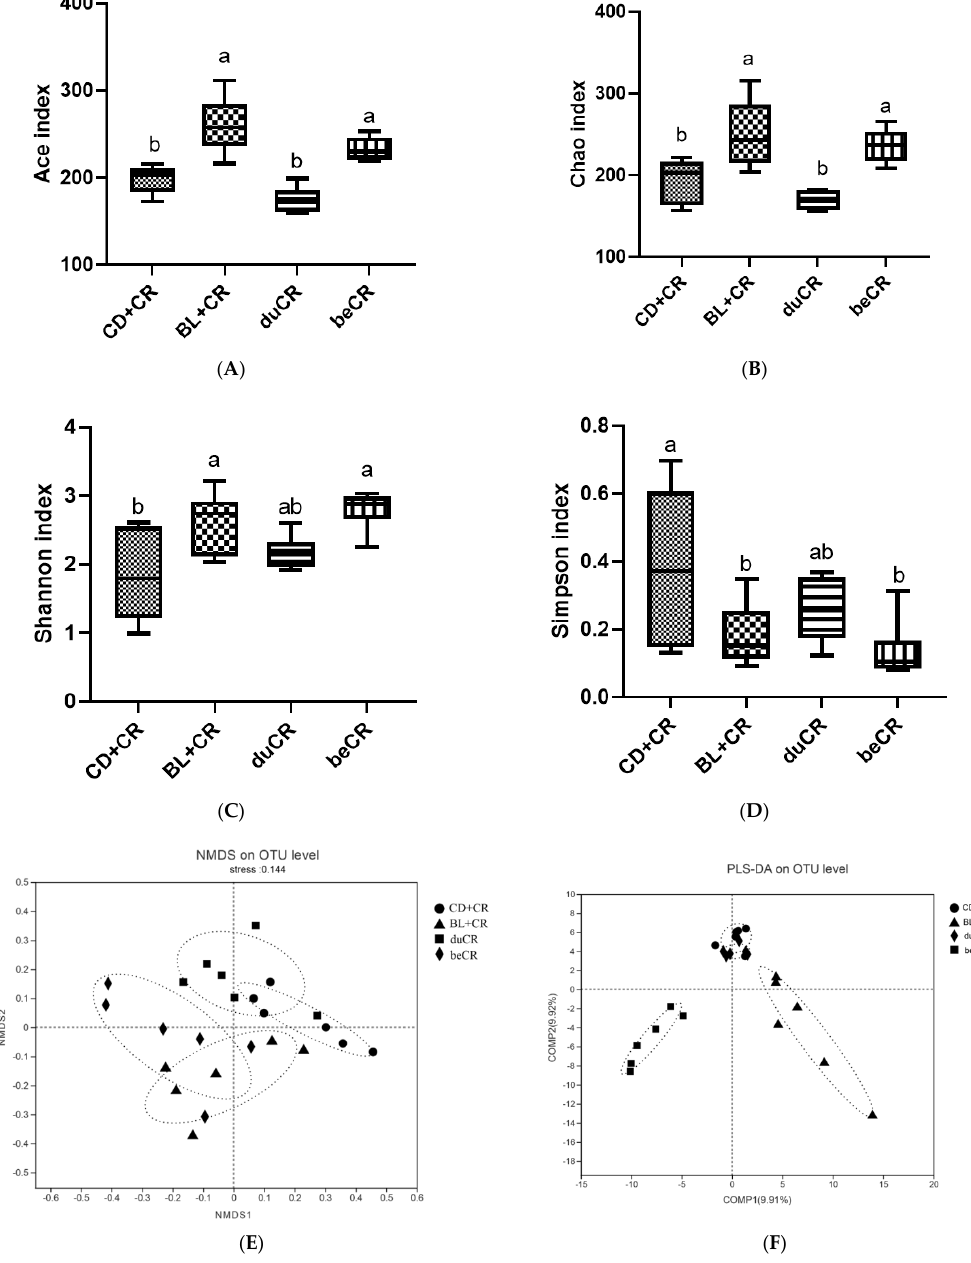
Figure 5. Effect of the beCR and duCR intervention on modulating alpha and beta diversity of intestinal flora. The richness of gut microbiota evaluated by ( A ) ACE index and ( B ) Chao index. The diversity of gut microbiota evaluated by ( C ) Shannon index and ( D ) Simpson index. ( E ) NMDS analysis on OTU level. ( F ) PLS-DA analysis on OTU level. The a, b means in the same bar without a common letter differ at p < 0.05.